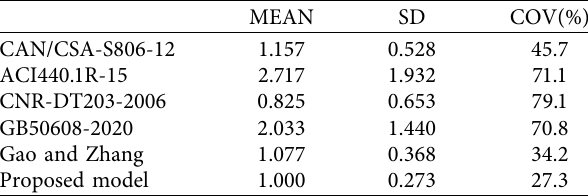
Table 5: Evaluation indicators of the models.